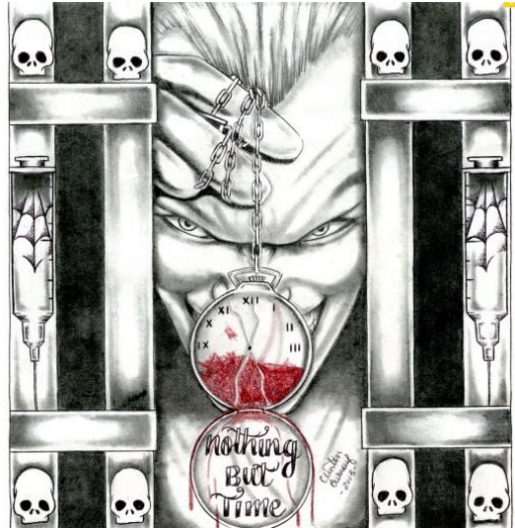
Figure 2: Image by CB (2013: